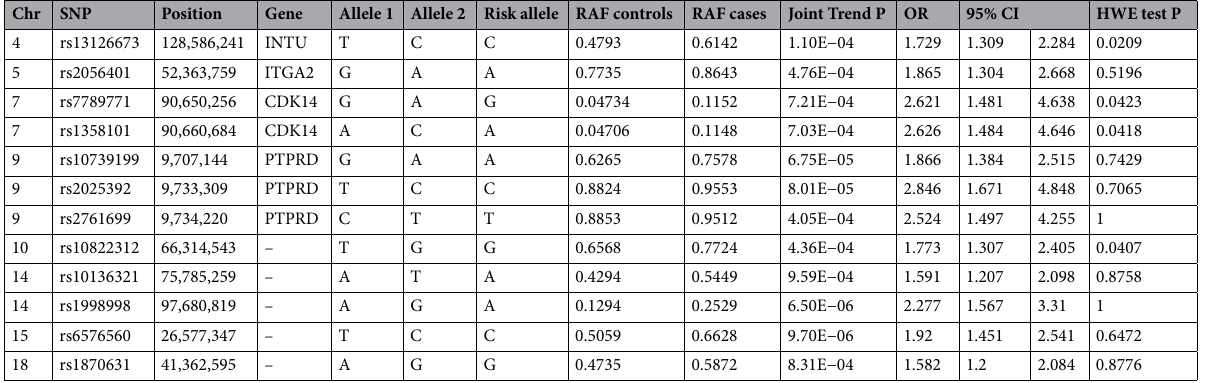
Table 3. SNPs with p values < 1 × 10 –3 in Joint analysis. RAF risk allele frequency, Trend P P vale of Trend